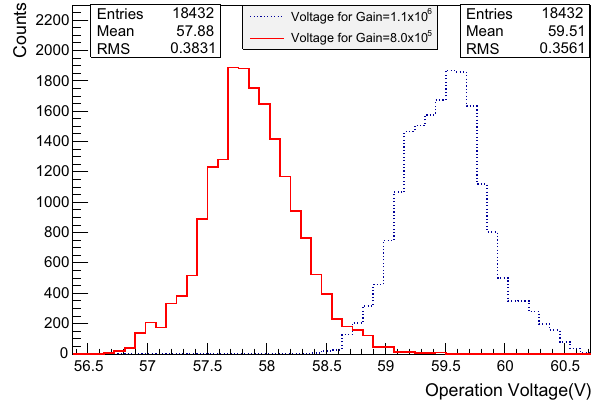
Fig. 12 Operation voltage distribution of 18,432 SiPMs in 18 WFCTA cameras. The dispersion of the operation voltage for gain=1 . 1 × 10 6 is mainlycomingfromtheprocessdifferencesinthesiliconwaferlots.The standard uncertainty of the measured operation voltage for g = 8 × 10 5 is 0.11